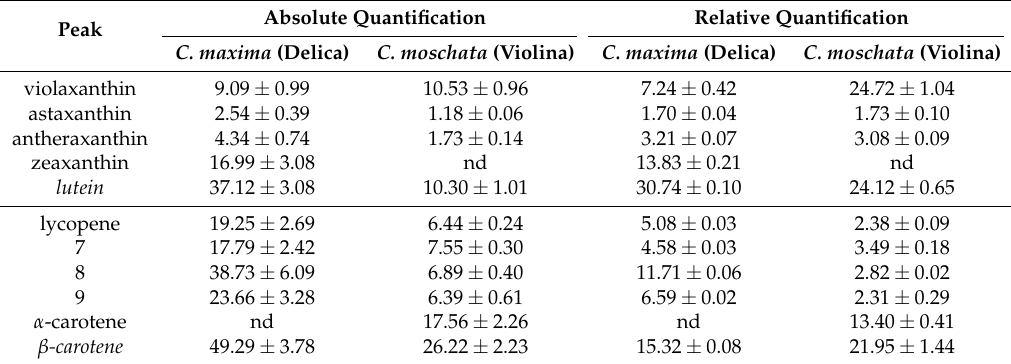
Table 2. Quantification of known and unknown chromatographic peak in fresh raw pumpkins. For each peak determination was reported: as absolute quantification ( µ g/g of fresh matter), by using external calibration curve of lutein (peaks from 1 to 5) and of β -carotene (peaks 6 to 11); as relative quantification in terms of peak